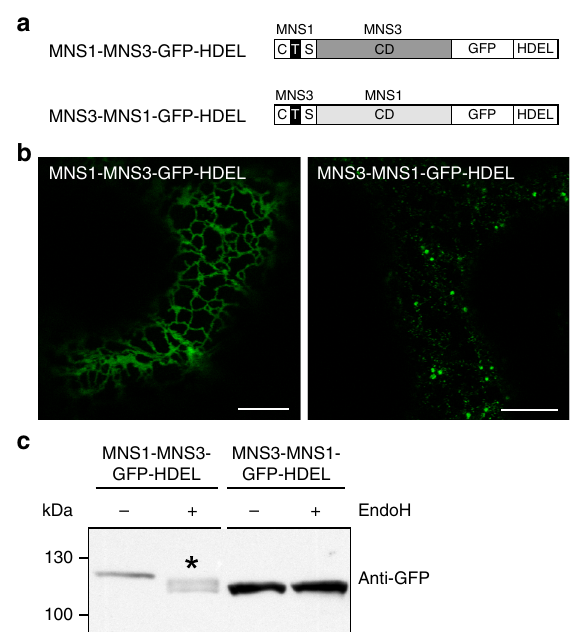
Fig. 6 The MNS3-CTS region contains signals that overrule HDEL-mediated ER retrieval. a Schematic illustration depicting the domain structure of the protein fusions MNS1-MNS3-GFP-HDEL, containing the MNS1-CTS region and MNS3 catalytic domain (CD), and MNS3-MNS1-GFP-HDEL, containing the MNS3-CTS region and MNS1 catalytic domain, both C-terminally tagged with GFP and the ER retrieval signal HDEL. b Confocal images showing N . benthamiana leaf epidermal cells transiently expressing MNS1- MNS3-GFP-HDEL or MNS3-MNS1-GFP-HDEL. Scale bars = 10 µ m. c Crude protein extracts from leaves of N . benthamiana Δ XF plants transiently expressing MNS1-MNS3-GFP-HDEL or MNS3-MNS1-GFP-HDEL were subjected to Endo H digestion followed by immunoblotting with anti-GFP antibodies. The asterisk marks the mobility shift. Source data are provided as a Source Data fi le NATURE COMMUNICATIONS| (2019) 10:3701